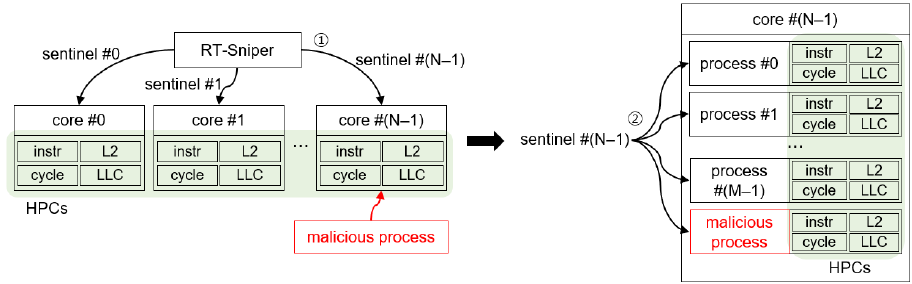
Figure 1. RT-Sniper mechanism: core-level filtering to process-level